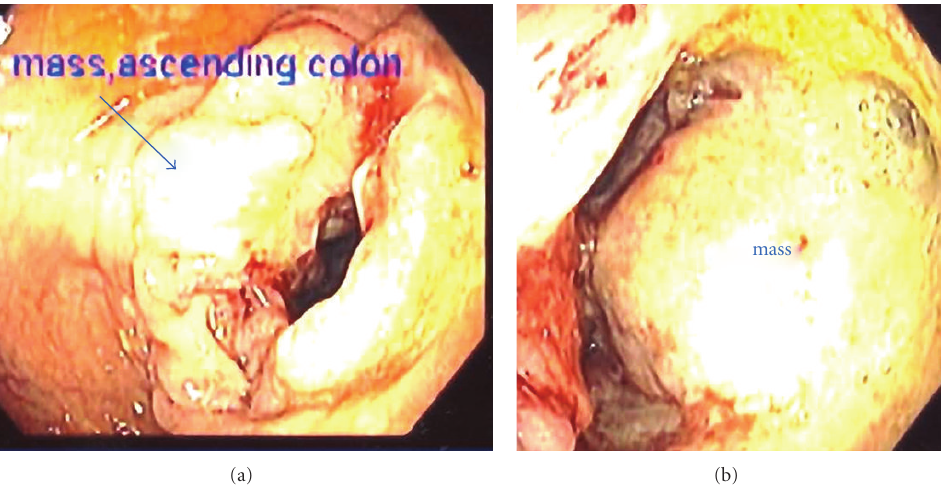
Figure 2: Colonoscopy revealed a circumferential fungating mass in the ascending colon measuring 4cm in